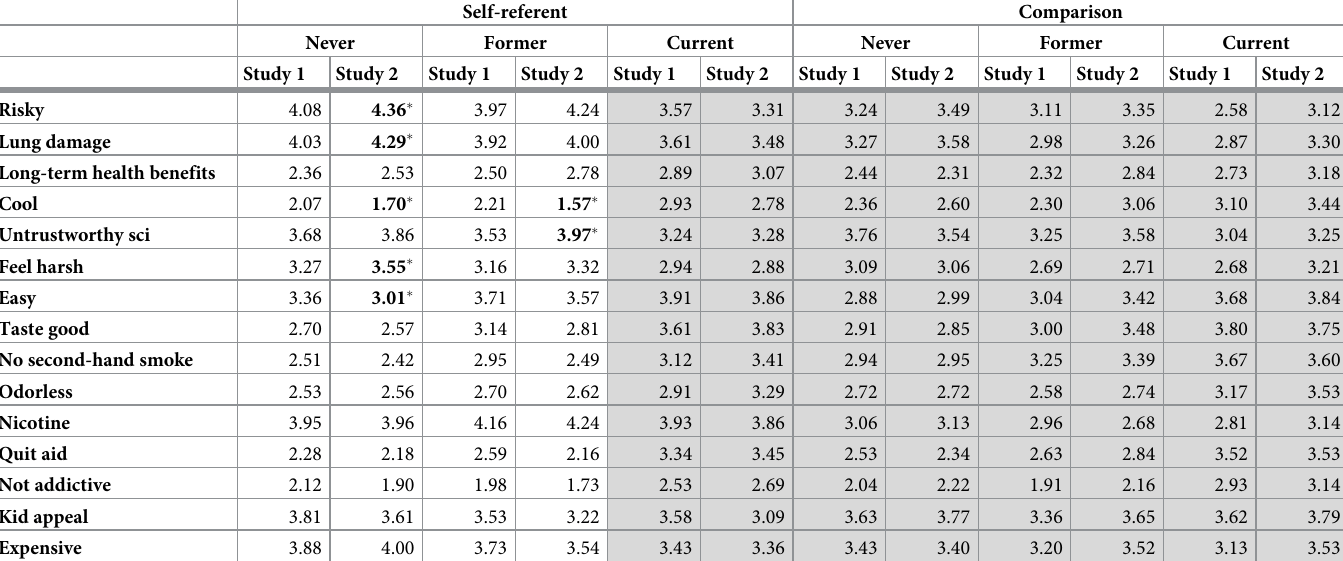
Table 3. E-cigarette belief change differences over time by user status.